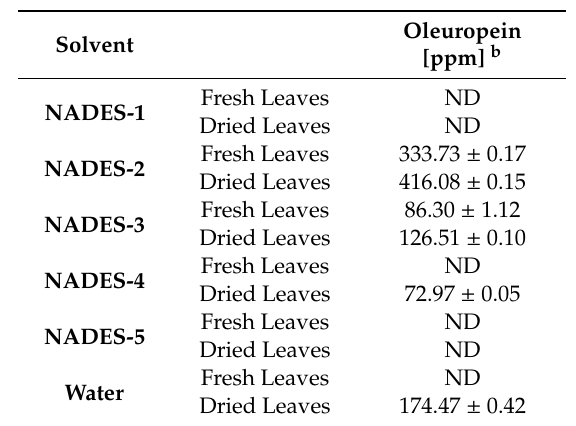
Table 3. Content of phenolic compounds in the examined olive leaf extracts (in NADESs or water) from HPLC analysis a